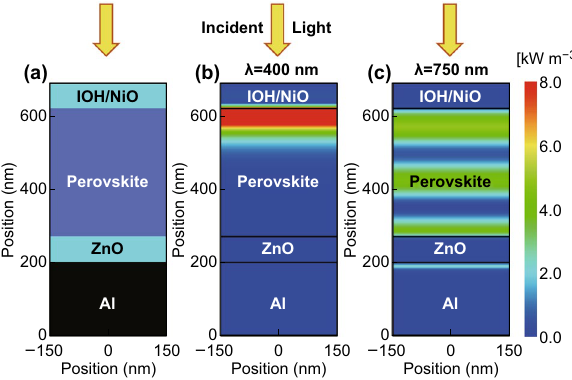
Fig. 10 a Schematic cross section, and simulated power density under monochromatic illumination of wavelength b 400 nm and c 750 nm for the flat perovskite solar